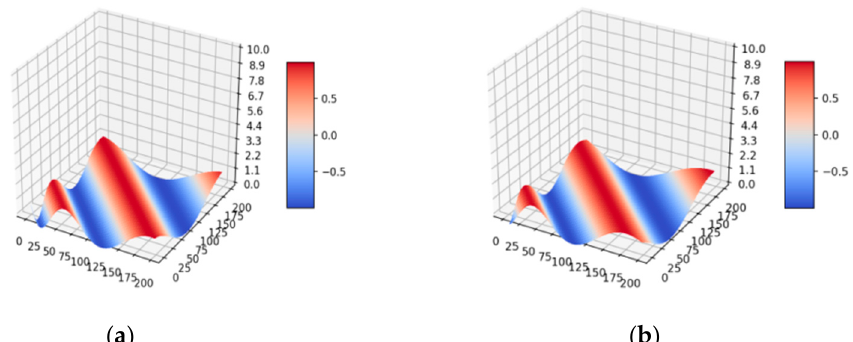
Figure 3. 3d surface map of feature map of the fifth convolutional layer: ( a ) is 01 gesture, ( b ) is 02